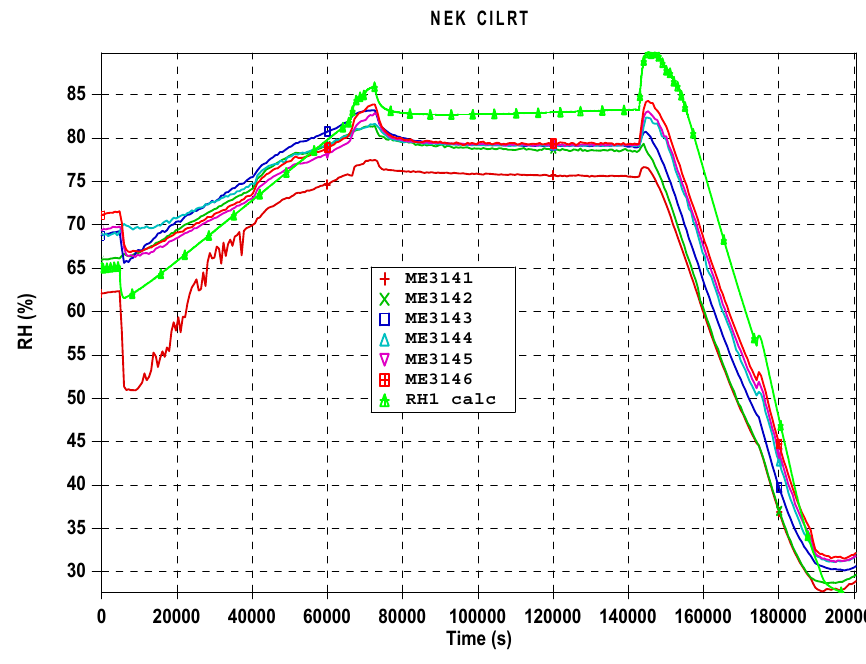
Figure 6. Measured and calculated containment relative humidity.